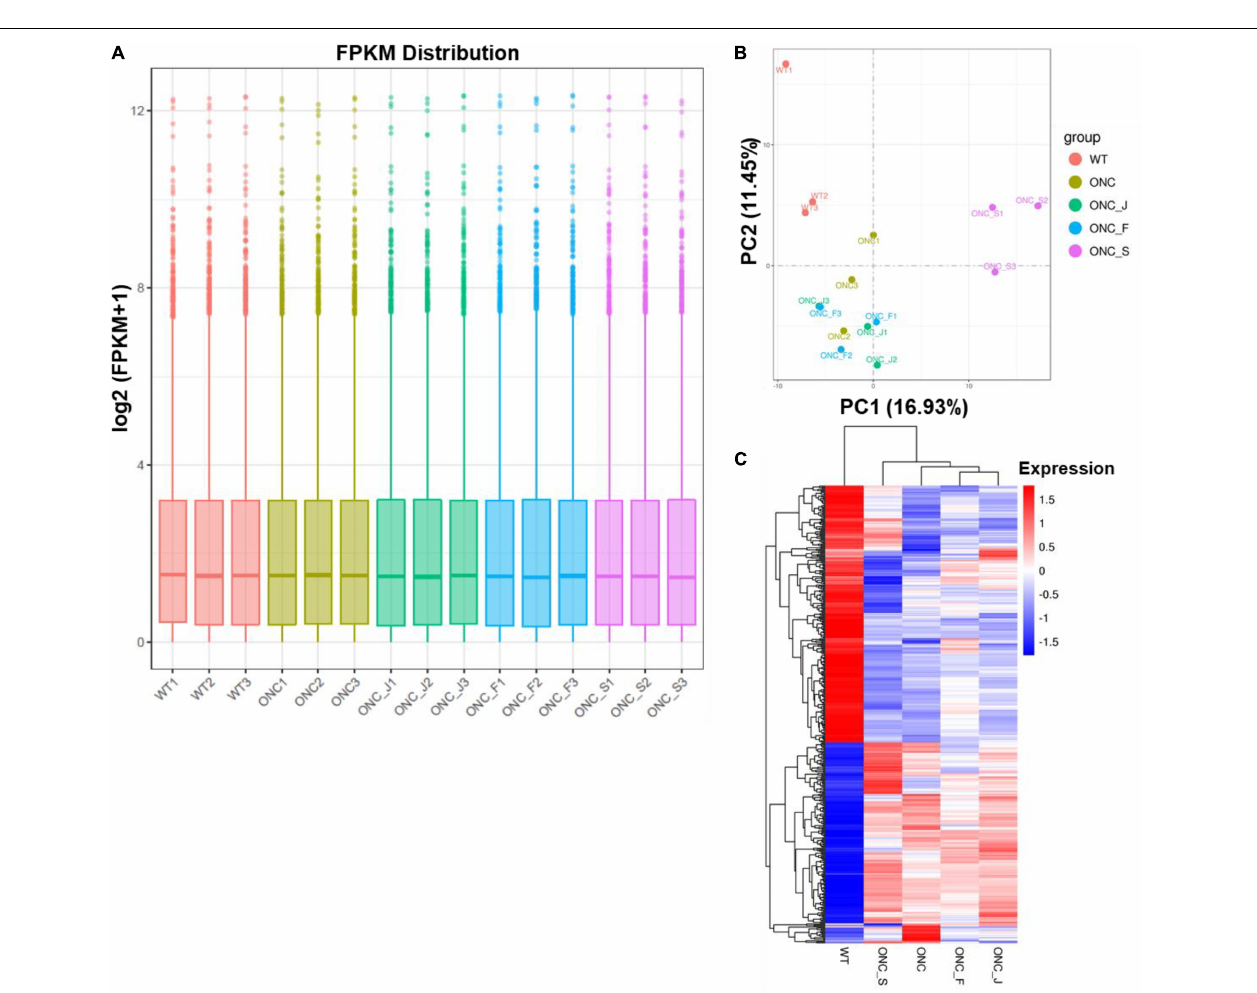
FIGURE 2 | Quantitative analysis of retinal gene expression. (A) Boxplot shows the overall range and distribution of FPKM value of gene expression of all the samples. (B) PCA analysis shows the differentiation among samples. (C) Cluster analysis of differentially expressed genes among samples and groups. The color of the heat map indicated the relative gene expression. The deeper red color indicates the higher gene expression, while the deeper blue color indicates the lower gene expression.